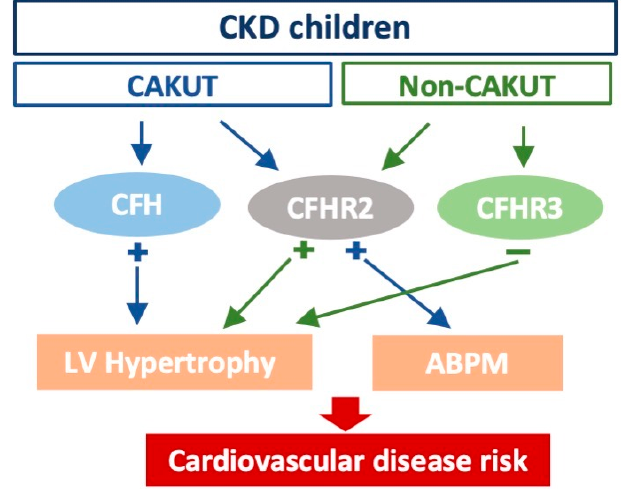
Figure 2. CFH and CFHR2 had a positive correlation with the LV mass, LVMI, and an abnormal ABPM profile in children with CKD and when subgrouped to the CAKUT population; CFHR3 had a negative correlation with the LV mass, LVMI in the non-CAKUT group.